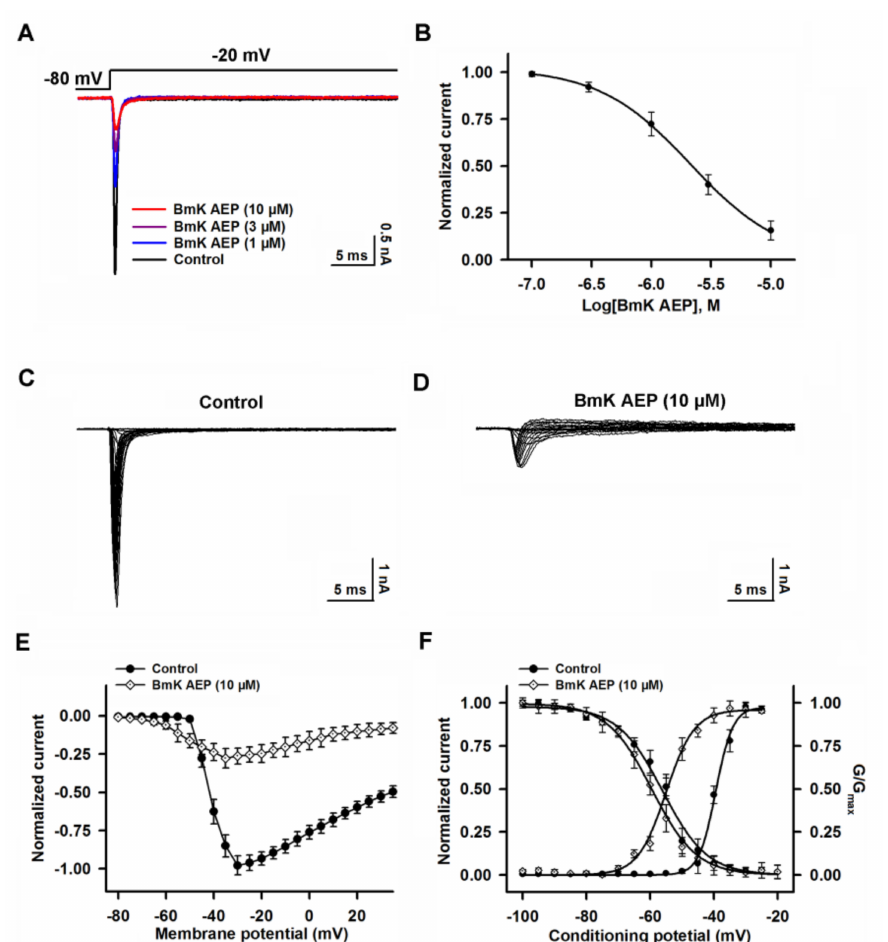
Figure 3. Influence of BmK AEP on hNa v 1.1 expressed in HEK-293 cells. ( A ) BmK AEP